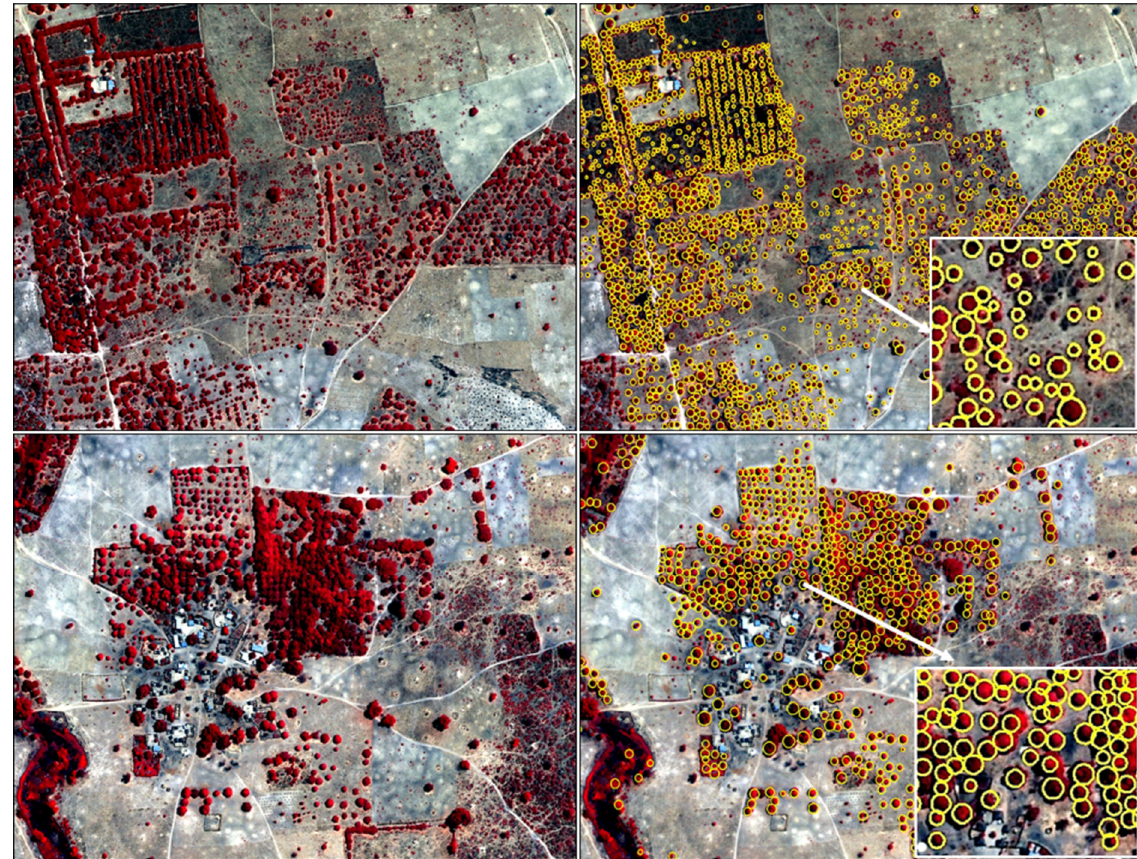
Figure 3. Example components of the landscape from VHR data ( left ) and processed crown projected areas for individual trees ( right ). The size of the circle represents the crown projected area (m 2 ). All trees in the 3336 ha test site were processed for crown projected area.